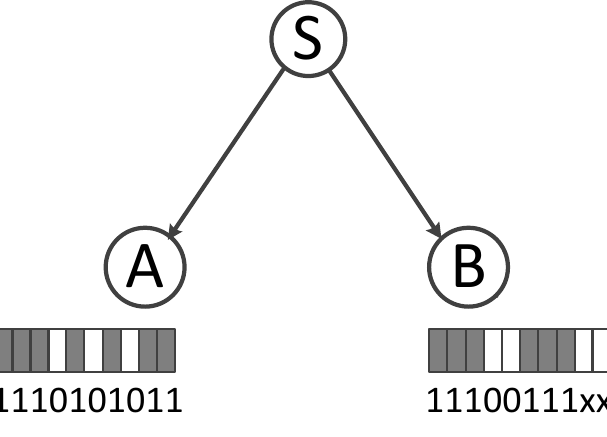
Figure 3. An example for bitmap